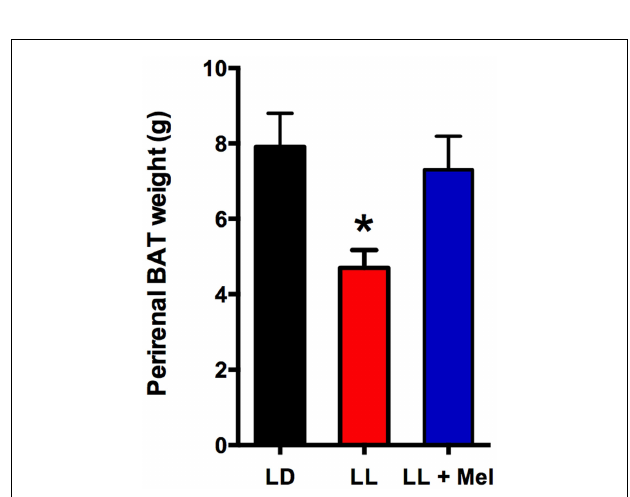
FIGURE 5 | Perirenal adipose tissue weight in 5days old lambs . Data are means ± SEM, LD, newborns gestated in ewes exposed photoperiod 12:12; LL, newborns gestated in ewes kept in continuous light from 60% gestation to term and LL + Mel, newborns gestated in ewes kept in continuous light but receiving an oral dose of 12mg melatonin at 1700h. N = 6 per group. * P < 0.05 vs. LD; ANOVA andTukey’s test.